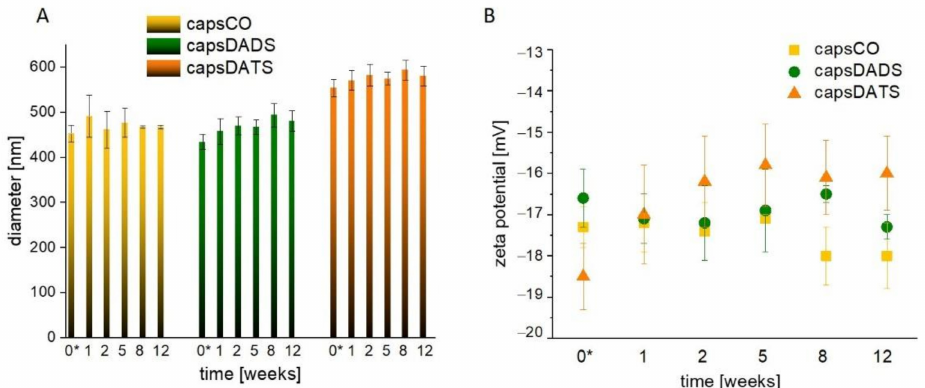
Figure 2. Time changes of averaged volume-weighted diameters ( A ) and averaged zeta potentials ( B ) of nanocapsules. Data presented as mean +/ − standard deviation (SD); n = 4. Observations were conducted for 12 weeks. *—measurement at the day of capsules